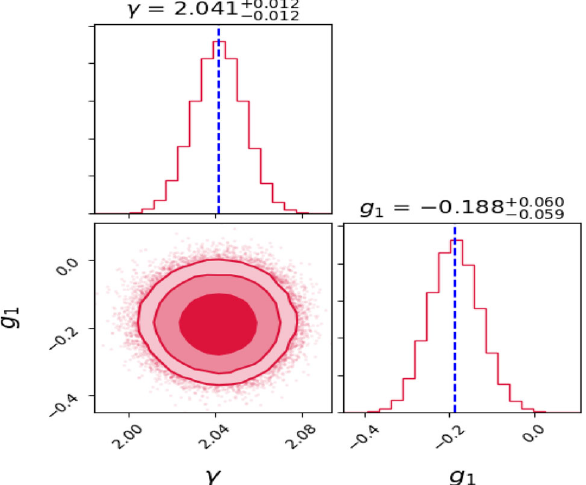
Fig. 5 ForIntermediatemassrangeSGLsample:The1Dmarginalized likelihood distributions along with 2D marginalized constraints show- ing the 68%, 95%, and 99% credible regions for the parameters γ (from the power law model describing the SGL systems) and g 1 (from the gas depletion factor g ( z ) ), obtained using the Corner python module [70]